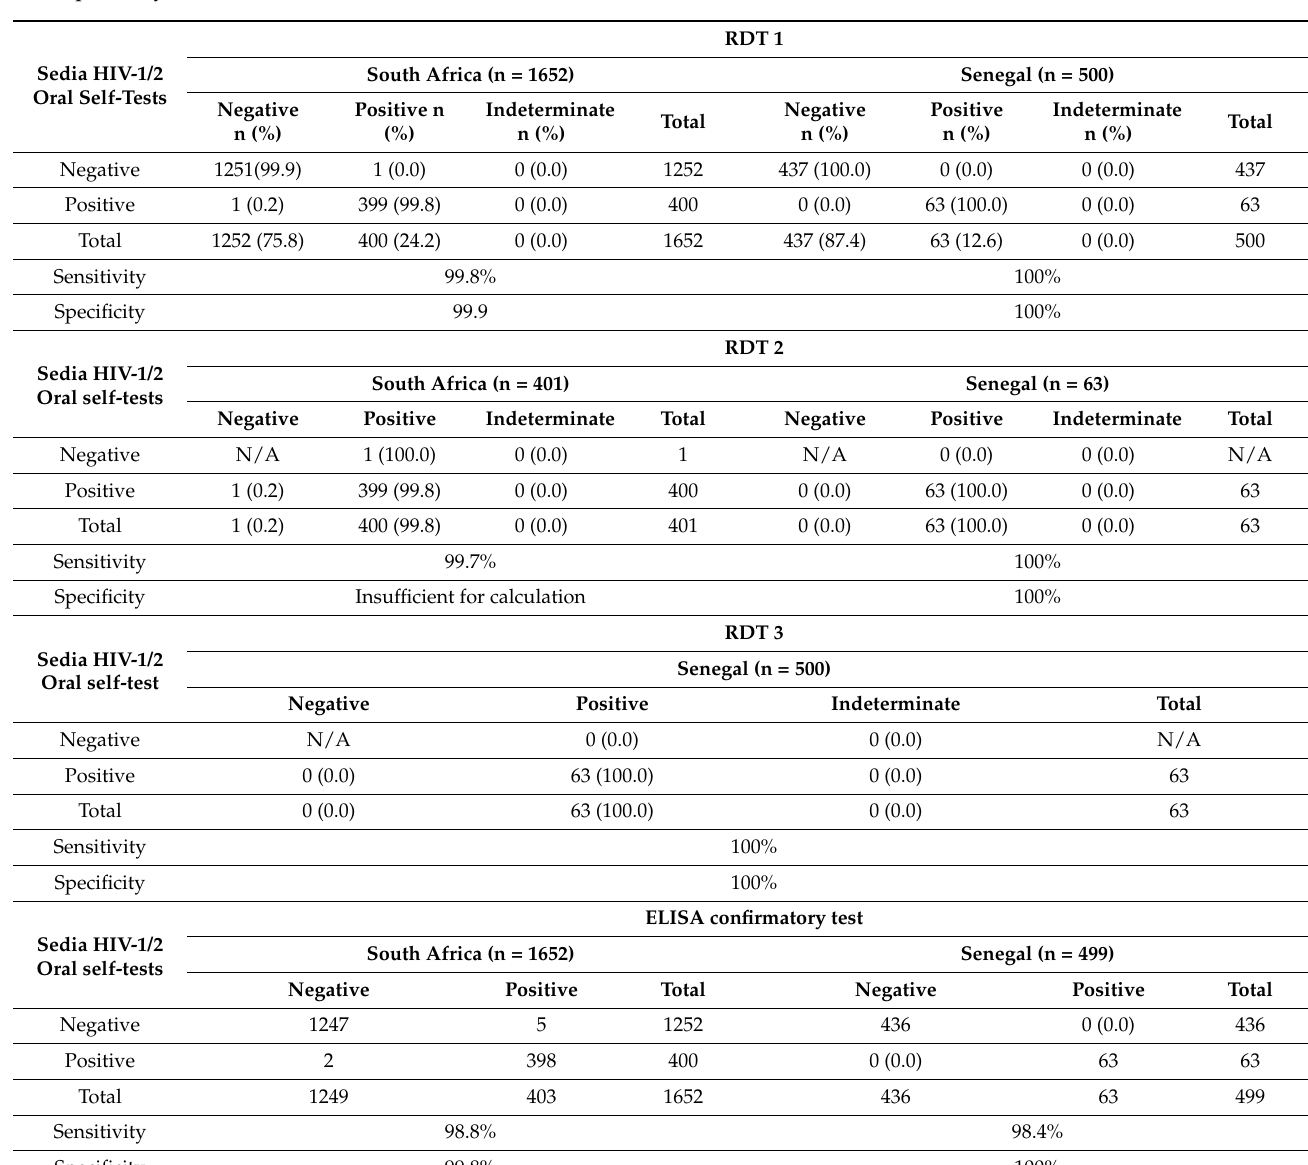
Table 2. Sensitivity and specificity of Sedia HIV-1/2 Oral self-tests vs. RDT 1, sensitivity and specificity of Sedia HIV-1/2 Oral self-tests vs. RDT 2, sensitivity and specificity of Sedia HIV-1/2 Oral self-test vs. RDT 3 (Senegal only), sensitivity and specificity of HIV-1/2 Oral self-tests vs.